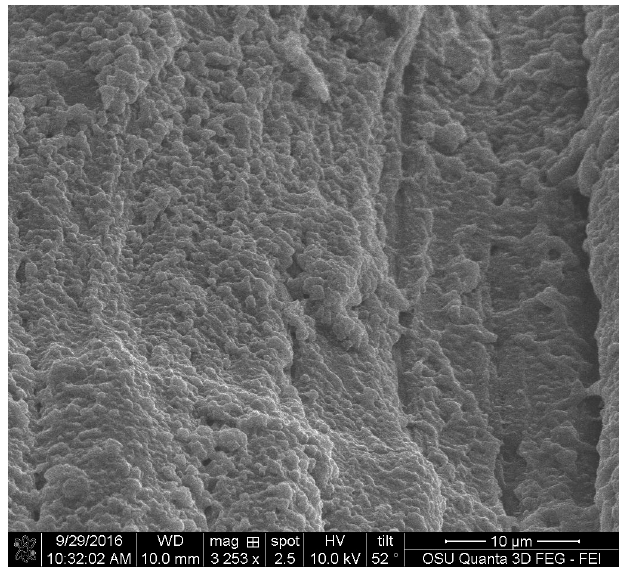
Figure 8. Amorphous layer formed by the extracted pigment of C. aeruginosa . Picture taken with an FEI QUANTA 600 F.